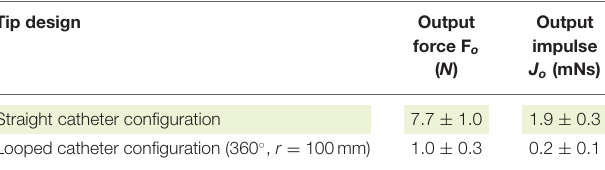
TABLE 3 | Overview of the results (mean ± standard deviation, n = 3) of the looped catheter